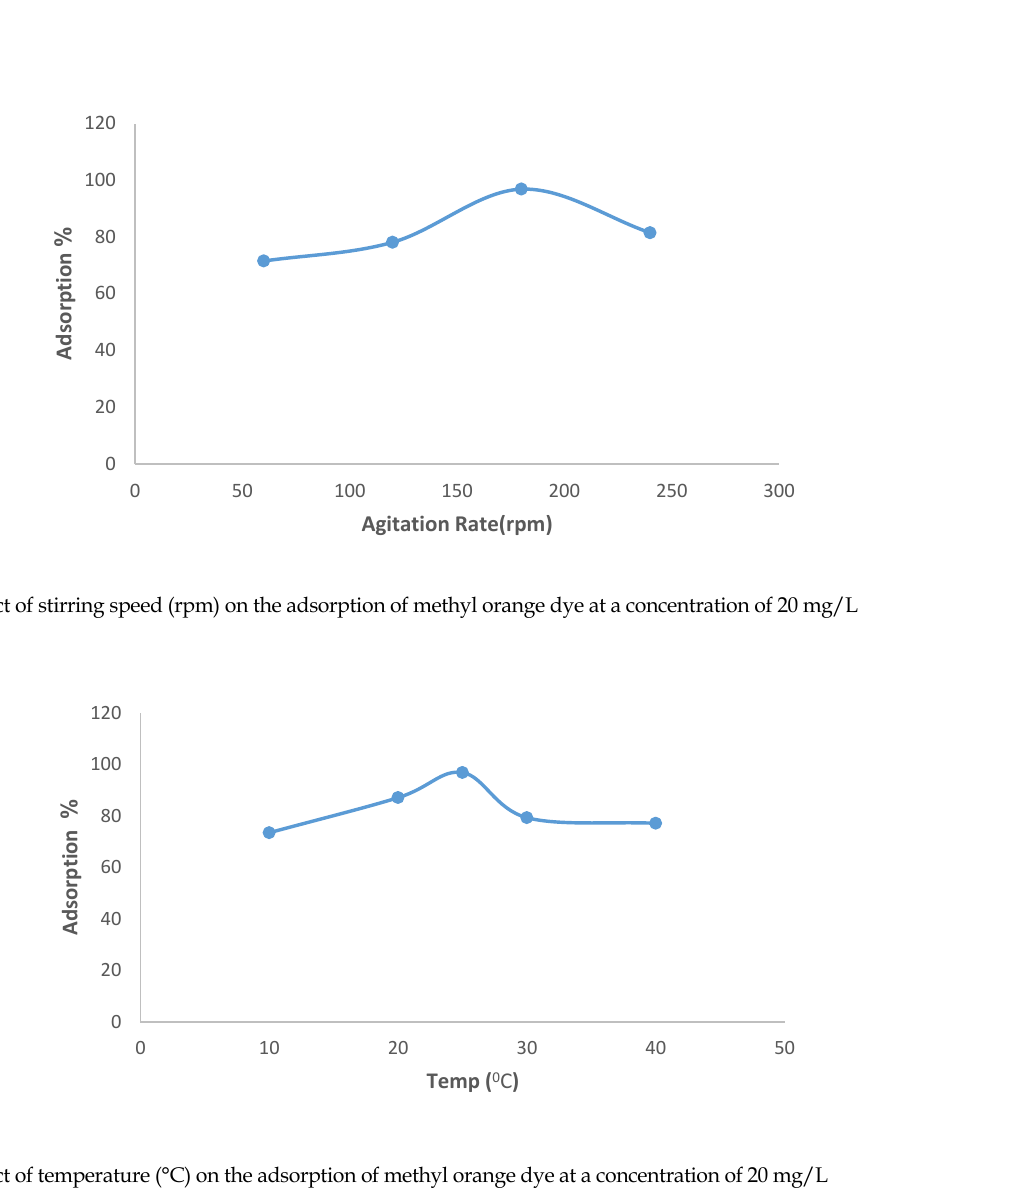
Figure 7. Effect of temperature (°C) on the adsorption of methyl orange dye at a concentration of 20 mg/L